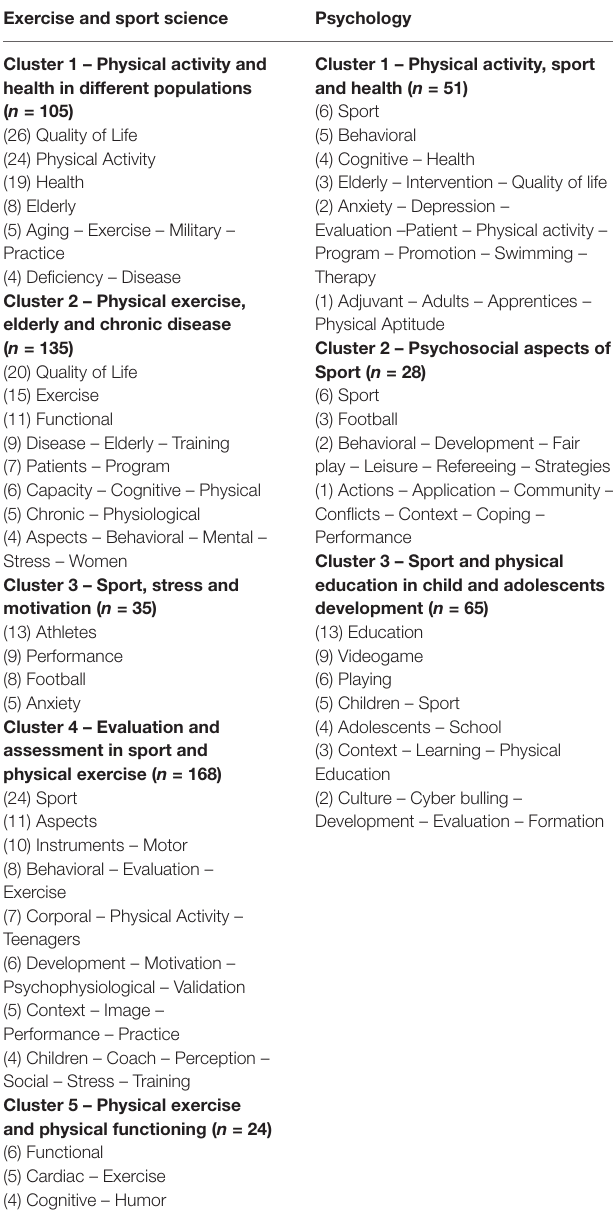
TABLE 1 | Keyword frequency for the Exercise and Sport Science and Psychology GPs